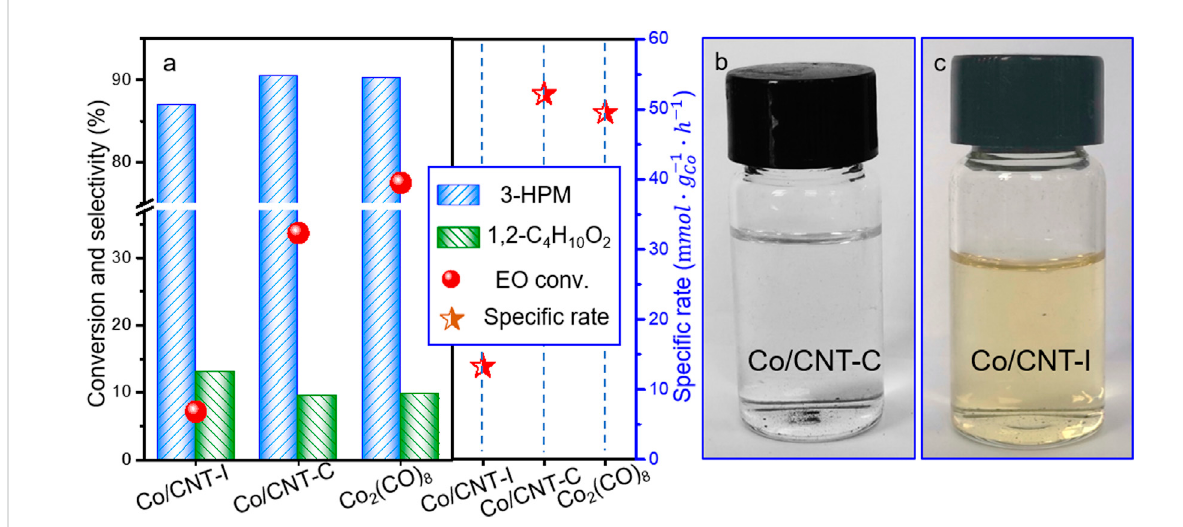
FIGURE 4 (A) Catalytic performances and speci fi crates and (B,C) electronic oftheup-layer solution bycentrifugation after reaction using Co/CNT-C and Co/CNT-I. Reaction condition: 60 ° C, 5 MPa CO for 5 h; Co/EO = 0.3/15 (0.1 g catalyst) for 20 wt% Co/CNT-I or Co/CNT-C; and Co/3- hydroxypyridine = 1:2, Co/EO = 1/15 for Co 2 (CO) 8 , balanced with methanol.